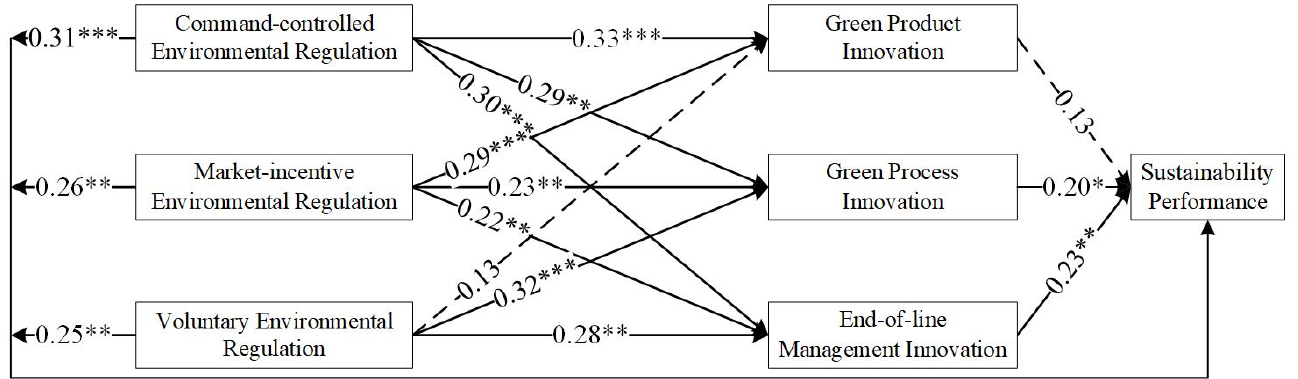
Table 5. Model fitting results for different regions.